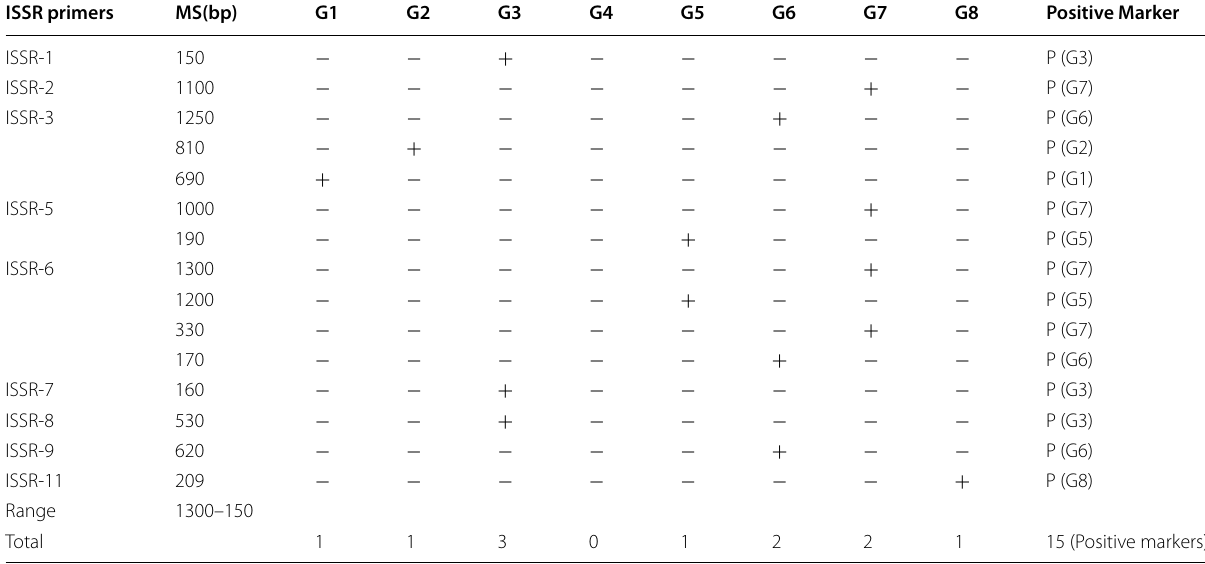
Table 9 Genetic similarity % in 8 sugar beet genotypes using 12 ISSR Primers Genetic